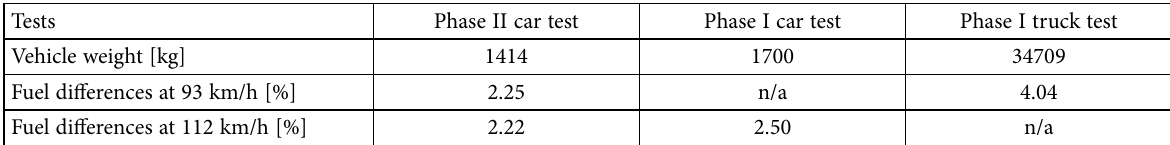
Table 4. Comparisons with Phase I